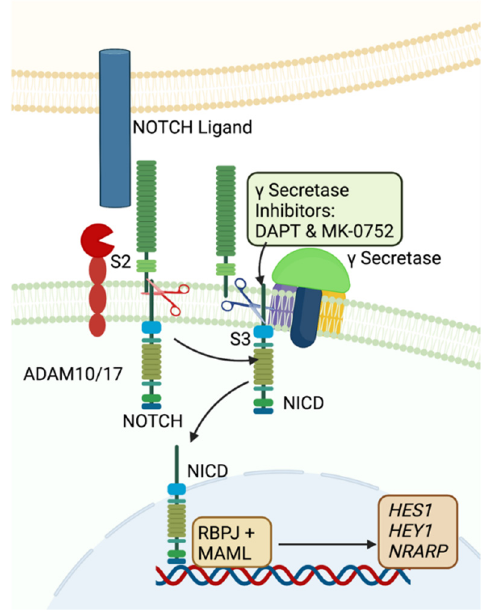
Figure 1. Schematic representation of the Notch signaling pathway. Notch signaling is activated when a NOTCH ligand binds to a NOTCH receptor on an adjacent cell. This triggers ADAM10/17